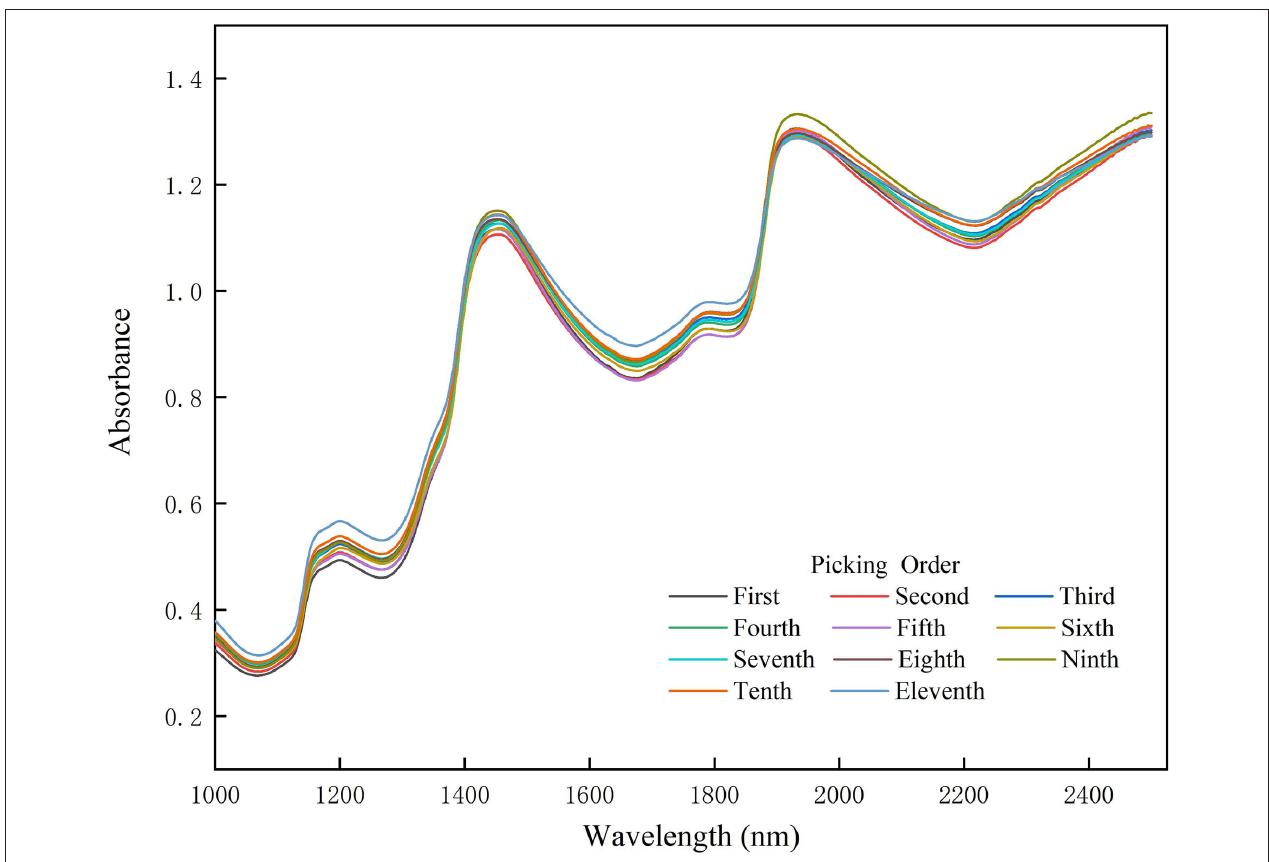
FIGURE 1 | Near infrared (NIR) spectra of citrus in different picking times in chronological order. Different picking orders are represented by different colors. Each line is the average spectrum of 12 fruit samples at each picking time.